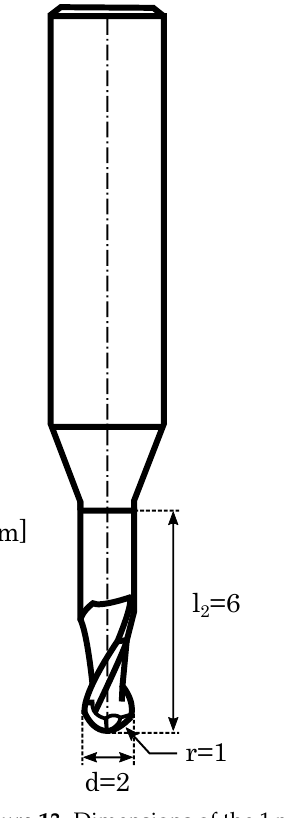
Figure 13. Dimensions of the 1mm ball end mill and the T-slot